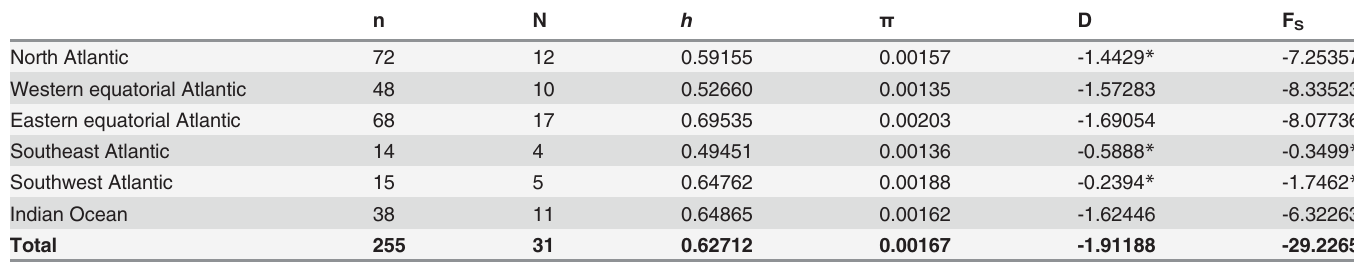
Table 4. Pseudocarcharias kamoharai population statistics — n, number of individuals; N, number of haplotypes; h , haplotype diversity; π , nucleotide diversity; D , value of Tajima D test; and F S , value of Fu